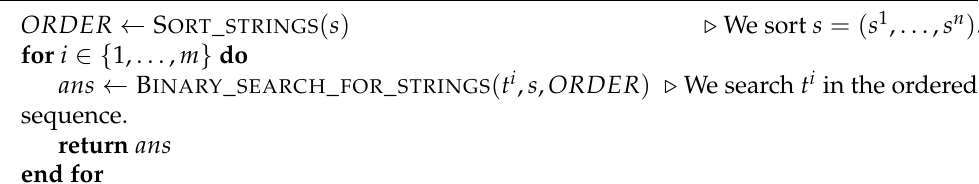
Algorithm 3 The Quantum Algorithm for Intersection of Two Sequences of Strings Problem using sorting